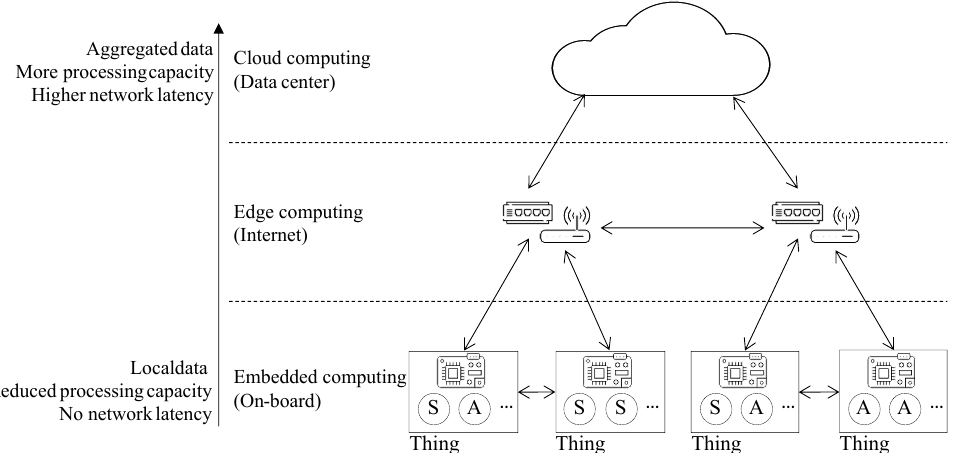
Figure 4. Data processing at embedded, edge, and cloud computing levels; moving from on-board to data center processing allows higher processing capability, broader data aggregates, and higher network latency. Things are composed of sensors, actuators, and processing